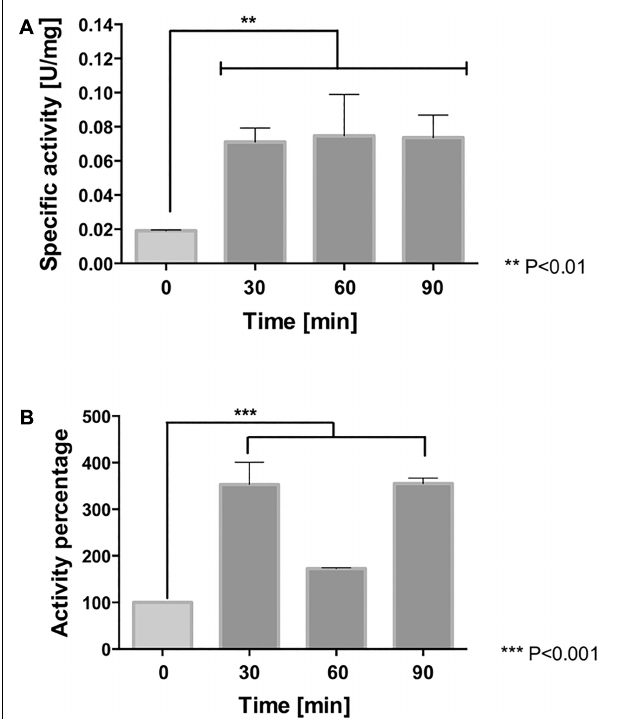
FIGURE 7 | Relative mRNA levels of oxidative stress related genes in L. ferriphilum DSM 14647. Relative expression of cytochrome c peroxidase ( ccp ) and the thioredoxin ( trx ) encoding genes was evaluated in cells treated with 100 mM NaCl. Data were normalized by the rrsB gene. Data represent the average of three independent experiments (bars indicate the value range). Statistical analysis was carried out by ANOVA